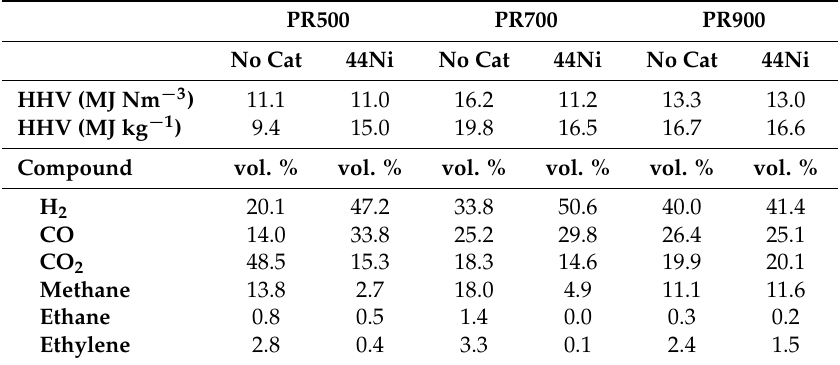
Table 7. Gases chromatography analysis (vol. %) and